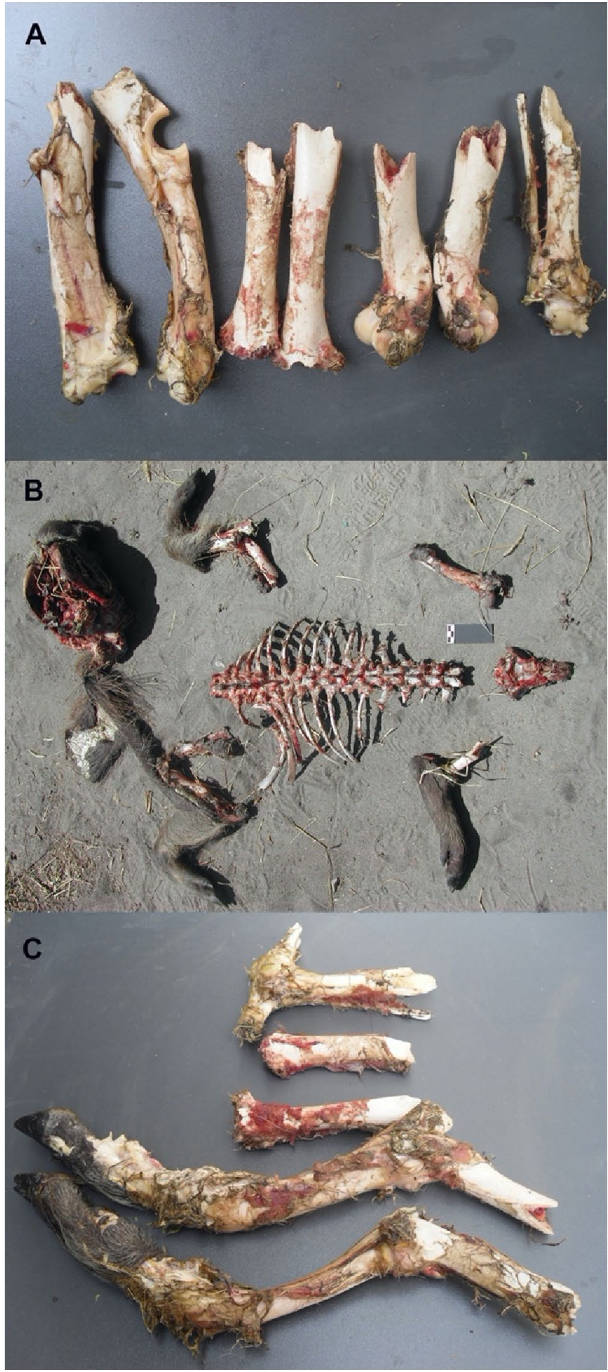
Figure 2. Examples of African warthog carcasses consumed by modern lions ( A–C ). Carcasses are completely defleshed by lions ( B ). Bone breakage is frequent on femora (both ends) and proximal humeri and tibiae ( A, C ). Radii are commonly more intact, with variable modification of the ulnar olecranon. Compare to the pattern seen on the Platygonus carcasses modified by Xenosmilus (Fig.